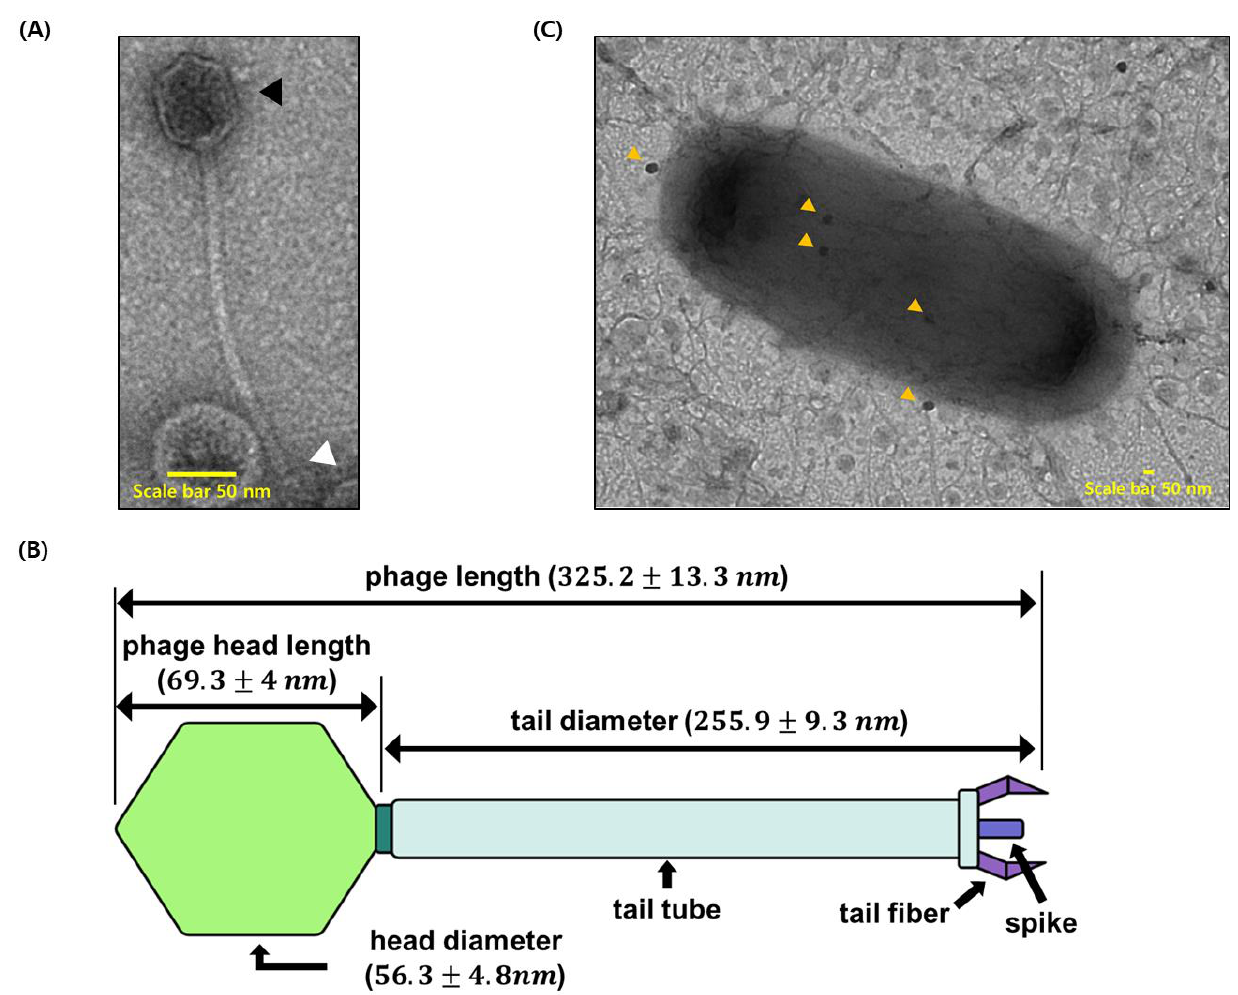
Figure 2. TEM images of phage Φ Ab1656-2. Φ Ab1656-2 was observed by TEM after being negatively stained with 2% uranyl acetate. ( A ) The morphology of Φ Ab1656-2 showed that it is under the Siphoviridae family. The black arrowhead indicates the phage head, and the white arrowhead indicates the phage tail. ( B ) Illustration showing the shape and dimensions of Φ Ab1656-2. Phage length and diameter were measured from the TEM images. ( C ) Φ Ab1656-2 and host A. baumannii ATCC 17978 interaction by TEM. Orange arrowhead indicates Φ Ab1656-2. The scale bar is 50 nm.